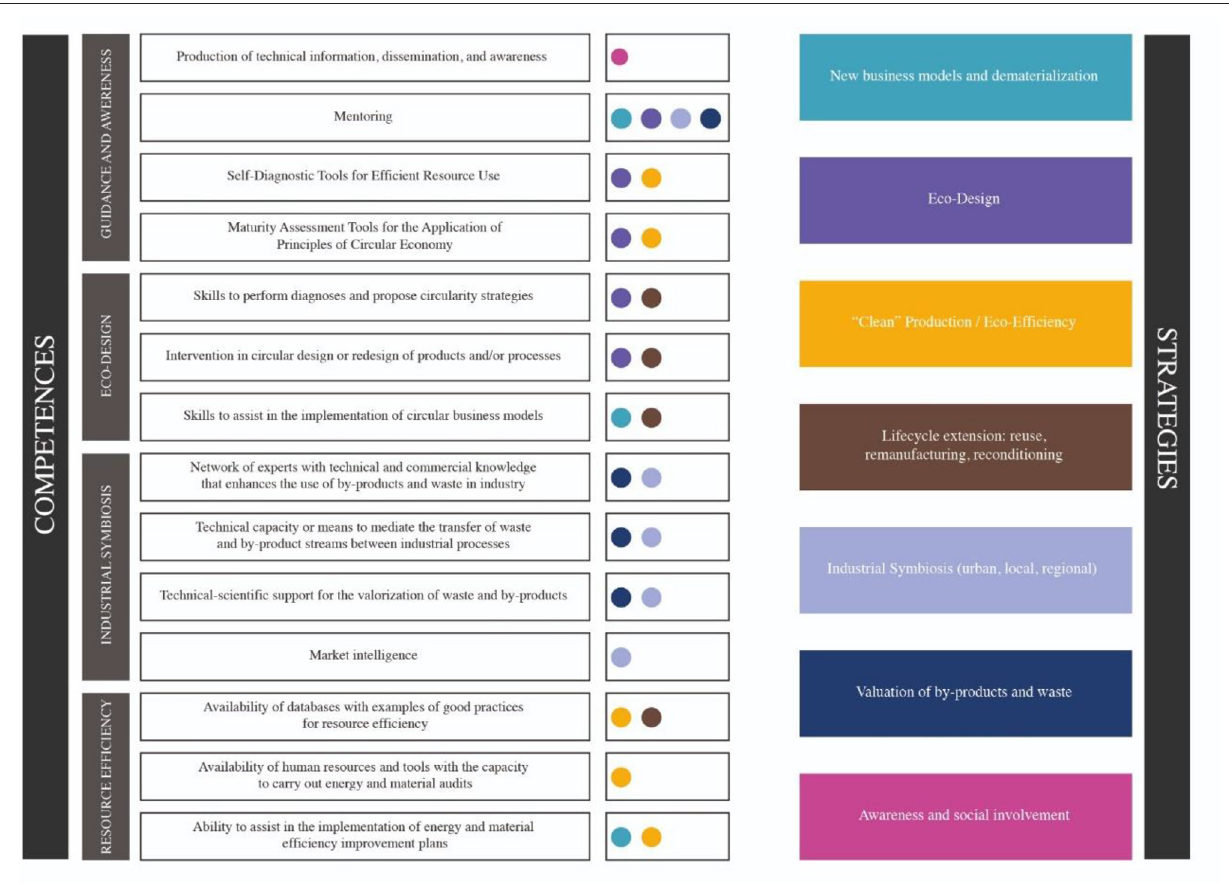
FIGURE 1 | Relevant competences to support the circular economy strategies foreseen in the Portuguese Circular Economy Action Plan